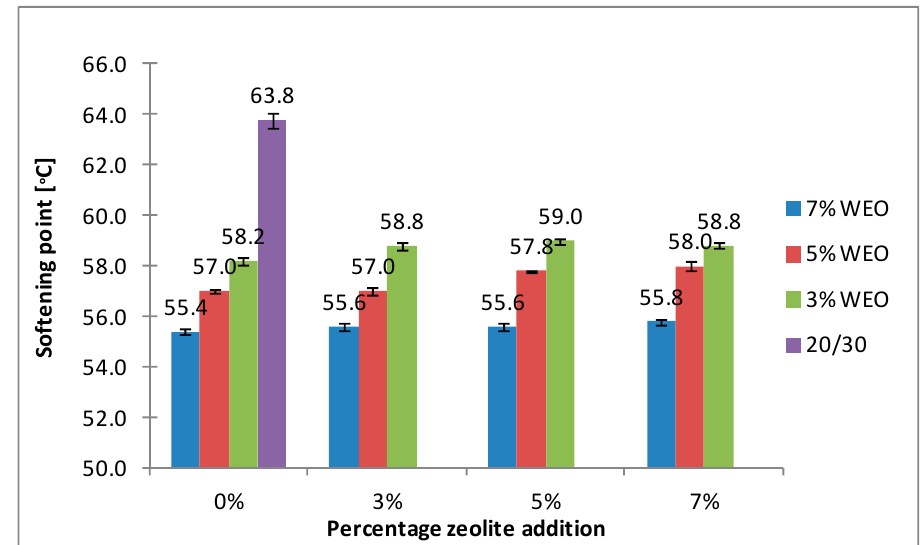
Figure 9. The results of softening point tests for the 20/30 asphalt with the addition of WEO and clinoptilolite zeolite.